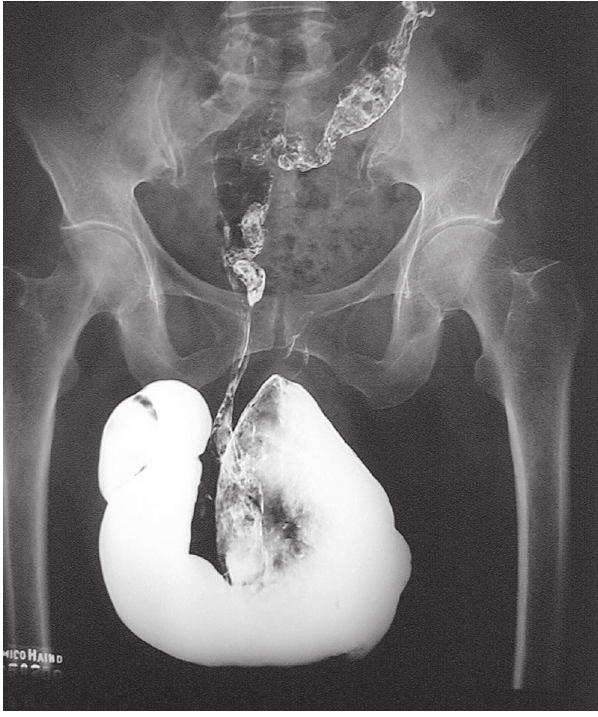
Figure 2 - Barium enema showing a perineal herniation with looping of the sigmoid colon into the hernial sac.